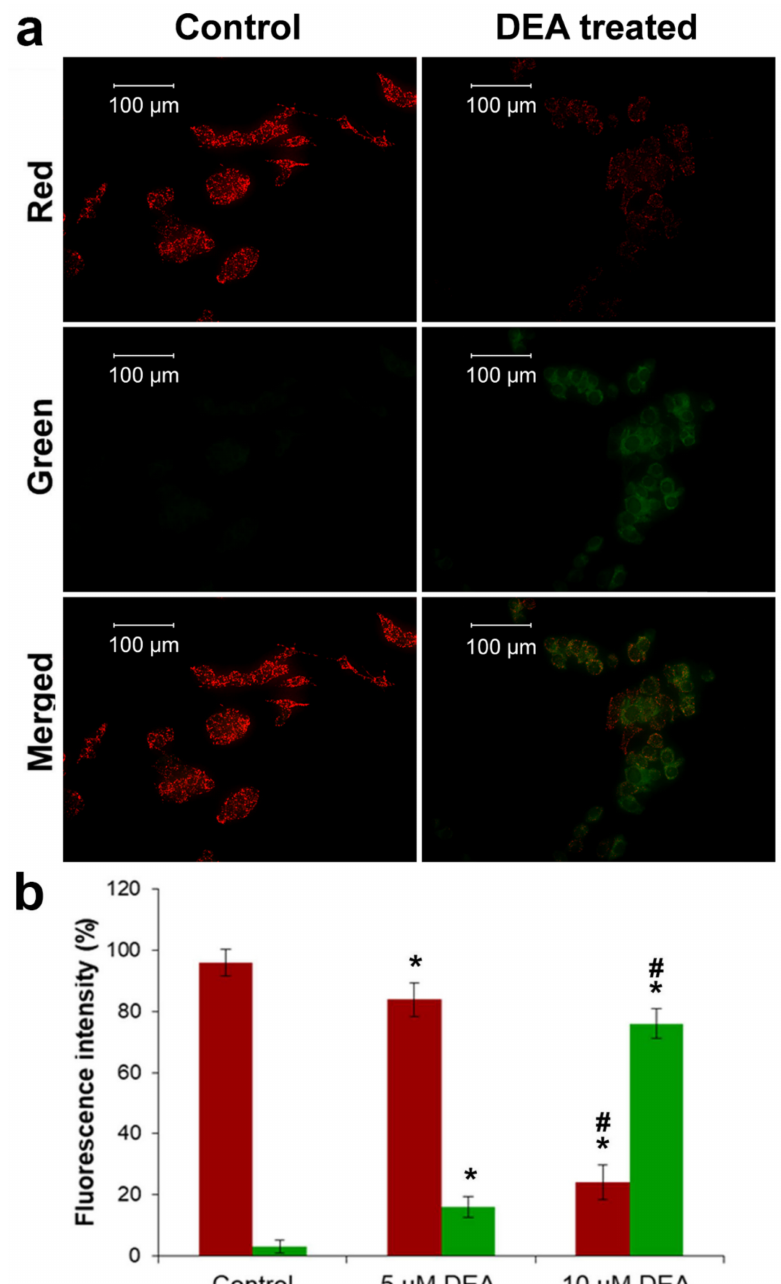
Figure 2. E ff ect of DEA on ∆Ψ m in B16F10 melanoma cells. Cells were treated with 5 or 10 µ M of DEA for 3 h. ∆Ψ m was assessed using the membrane potential-dependent fluorescent dye, JC-1. Red and green fluorescence indicates normal and depolarized ∆Ψ m , respectively. ( a ) Representative fluorescence images in the red, green, and merged channels of cells treated with 10 µ M of DEA. ( b ) Quantitative assessment of ∆Ψ m , expressed as the % of fluorescence intensity (means ± SEM of three independent experiments). Quantitative comparisons are true within the same color only. Red and green bars denote red and green fluorescence, respectively. * and # indicate a significant di ff erence relative to the control and 5 µ M of DEA, respectively ( p <